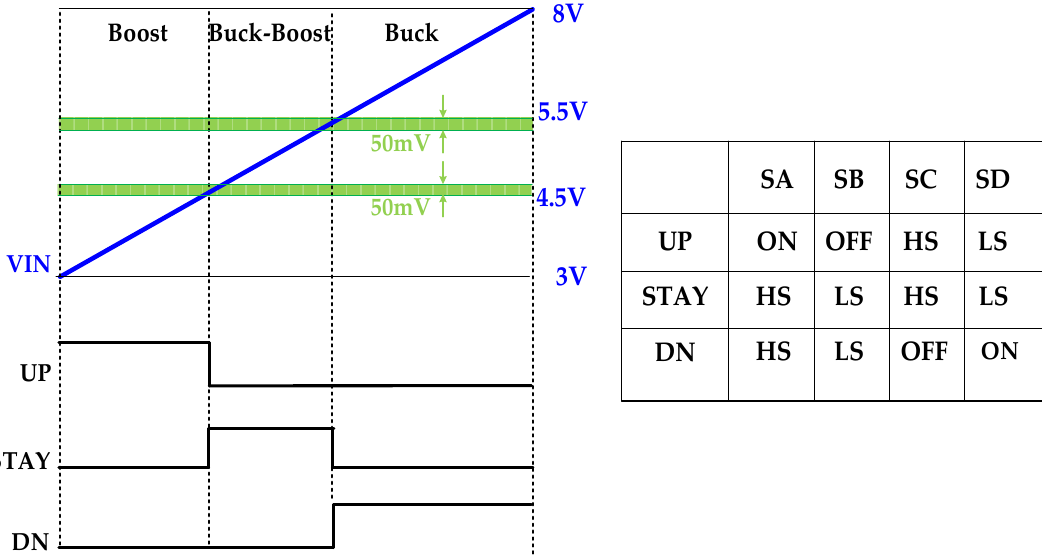
Figure 2. Triple-mode operation principle timing diagram.